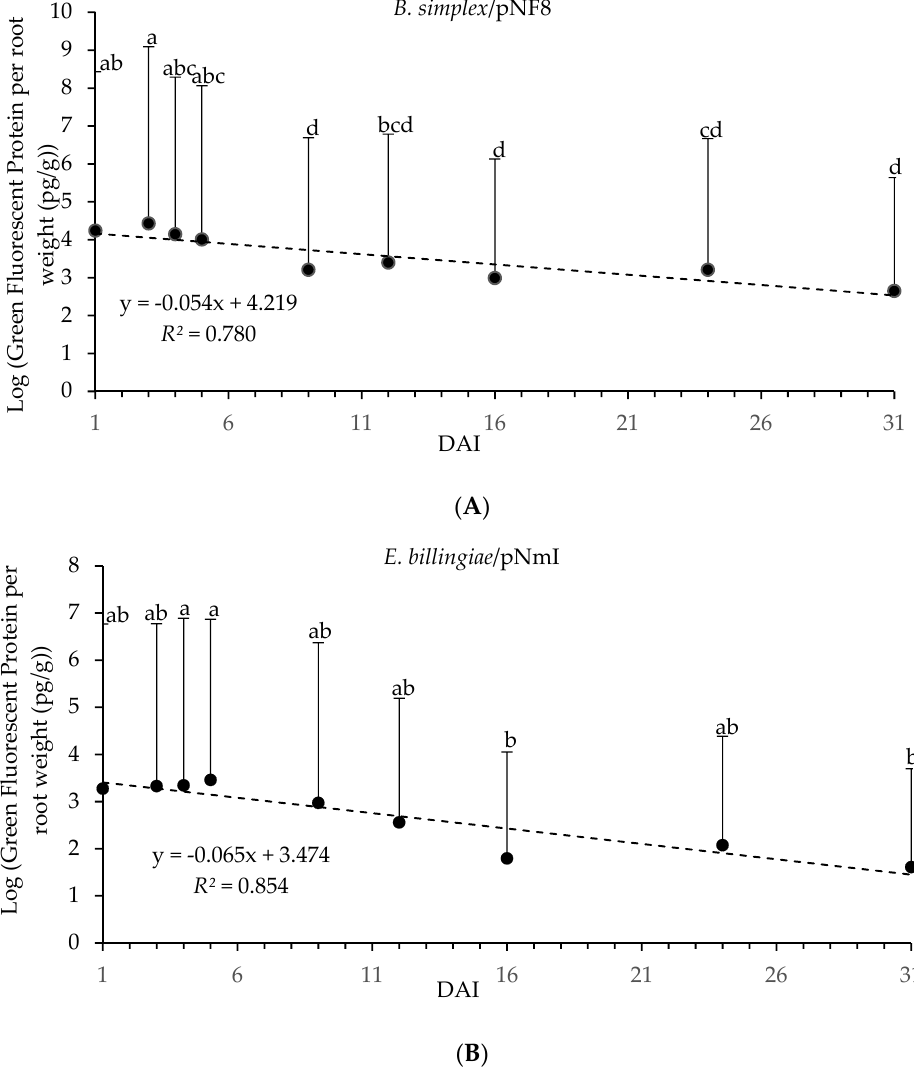
Figure 4. Log transformed GFP content (pg) from E. billingiae / pNmI ( B ) and B. simplex / pNF8 ( A ) per root weight (g) over 31 days determined by ELISA. Error bars indicate the pooled standard deviation calculated from the standard deviation of the measured GFP concentration of the replicates and the standard deviation obtained for the plant weights. Statistically significant differences of p < 0.05 in GFP content in E. billingiae /pNmI ( B ) or B. simplex /pNF8 ( A ) over time are presented with lowercase letters.